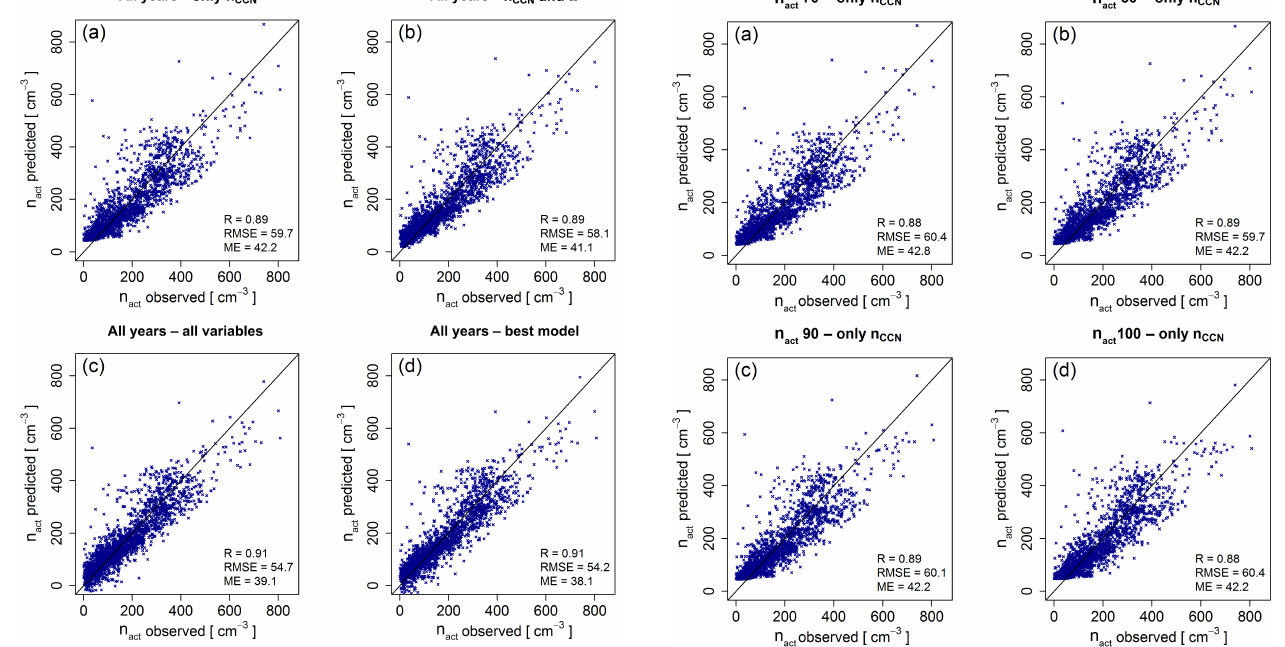
Figure 6. The number of cloud droplets calculated using a statistical model, based on a regression analysis including only the number of potential CCN, plotted against the observed number of residuals. Potential CCN are considered to be all particles with a diameter (a) larger than 70nm, (b) 80nm, (c) 90nm, and (d)